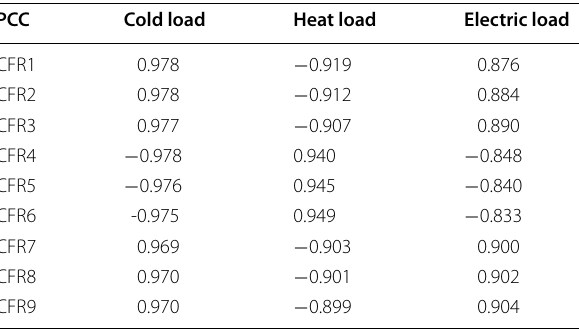
Table 2 PCC between coupled features and